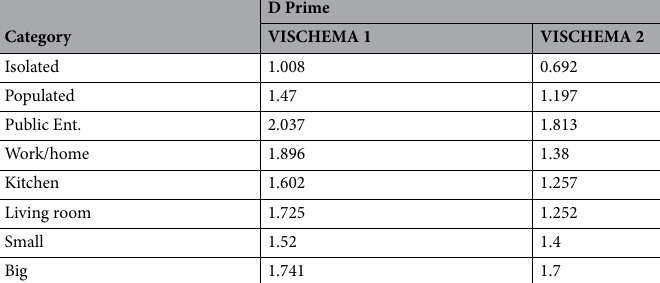
Table 2. D-Prime analysis of human memory for each category in the Vischema 1 and Vischema 2 datasets. High values clearly indicate that the memory signal for the given image category is strong and thus image memorability for human observers is high. Certain categories have stronger signals than others, possibly due to easier or more available encoding schemas for that category among the human participants.